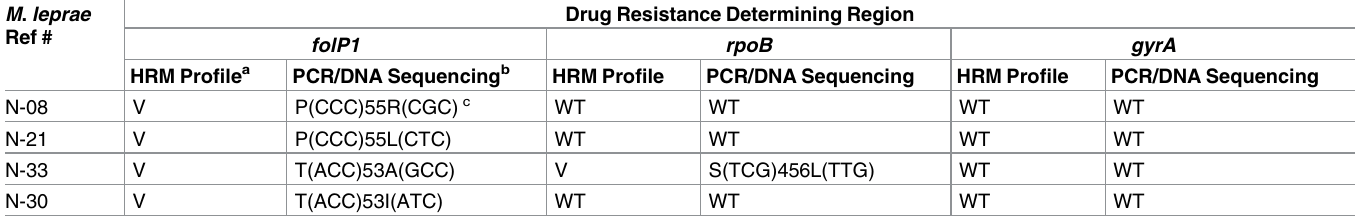
folP1 DRDR associated with the DDS-R genotype evaluated thus far. One of the four DDS-R Table 3. M . leprae drug-resistant mutants in clinical specimens from leprosy patients identified using molecular drug susceptibility assays. M . leprae Ref